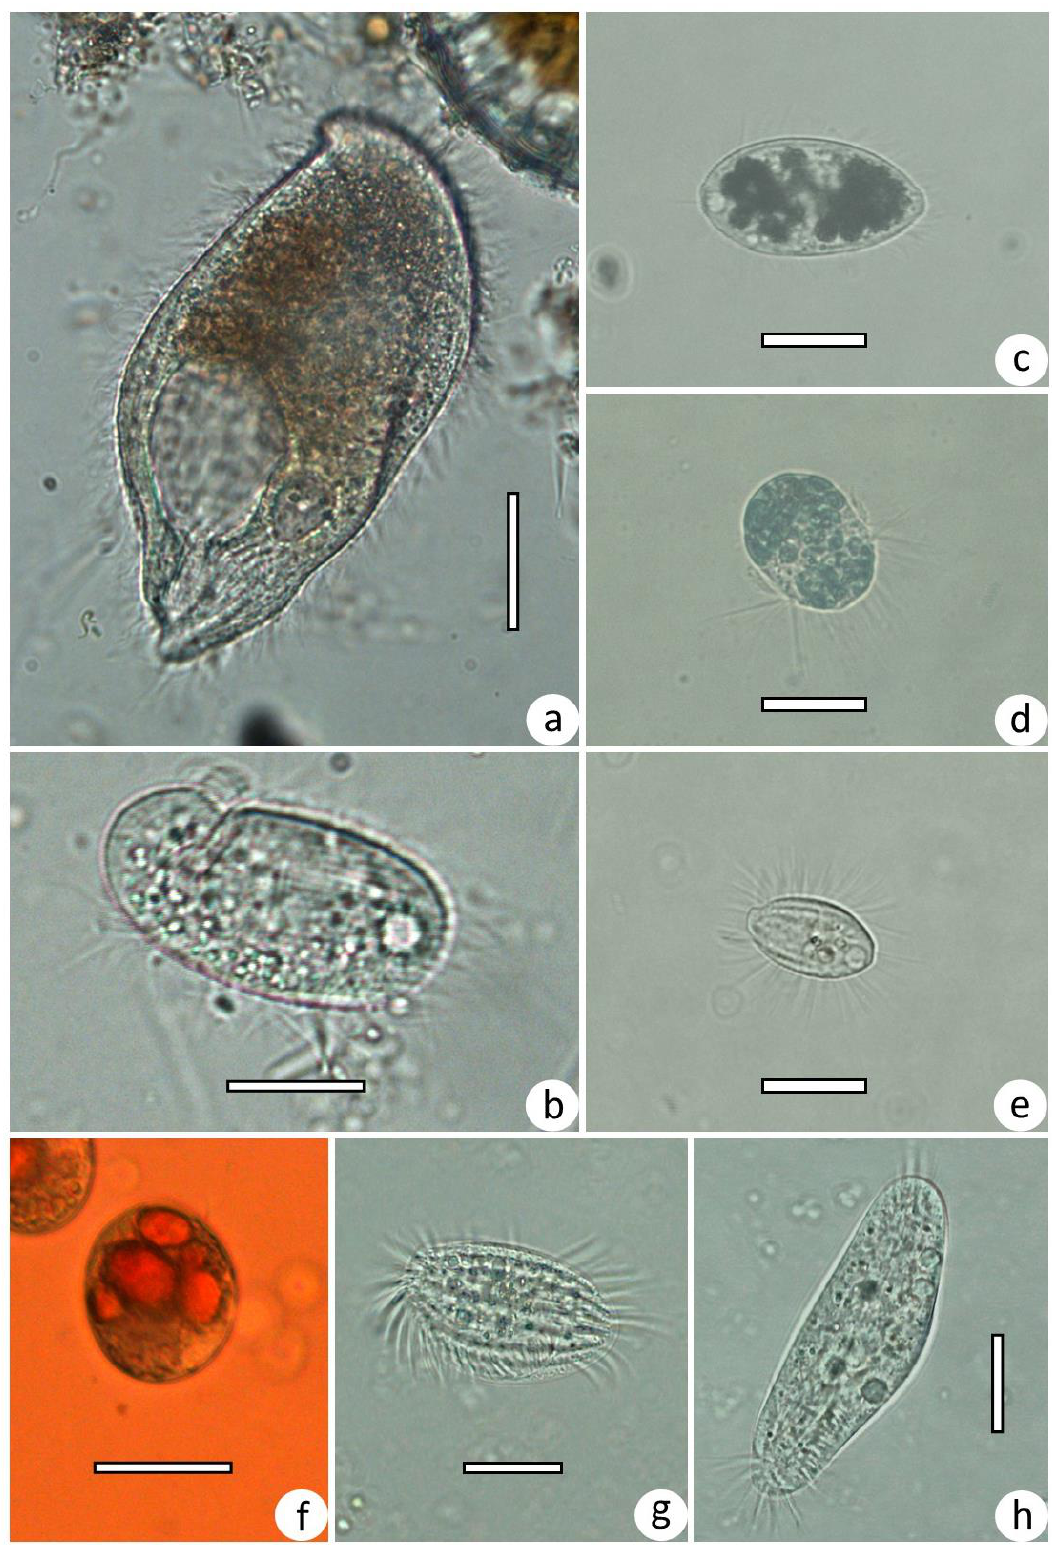
Figure 6. Light microscopy of the ciliates observed: ( a ) Metopus sp.; ( b ) Plagiopyla sp.; ( c ) Uronema sp.; ( d ) Mesodinium sp.; ( e ) Cyclidium sp.; ( f ) Prorodon sp. (fluorescent microscopy); ( g ) Euplotes sp.; ( h ) Oxytricha sp. Scale bars: 20 µm.